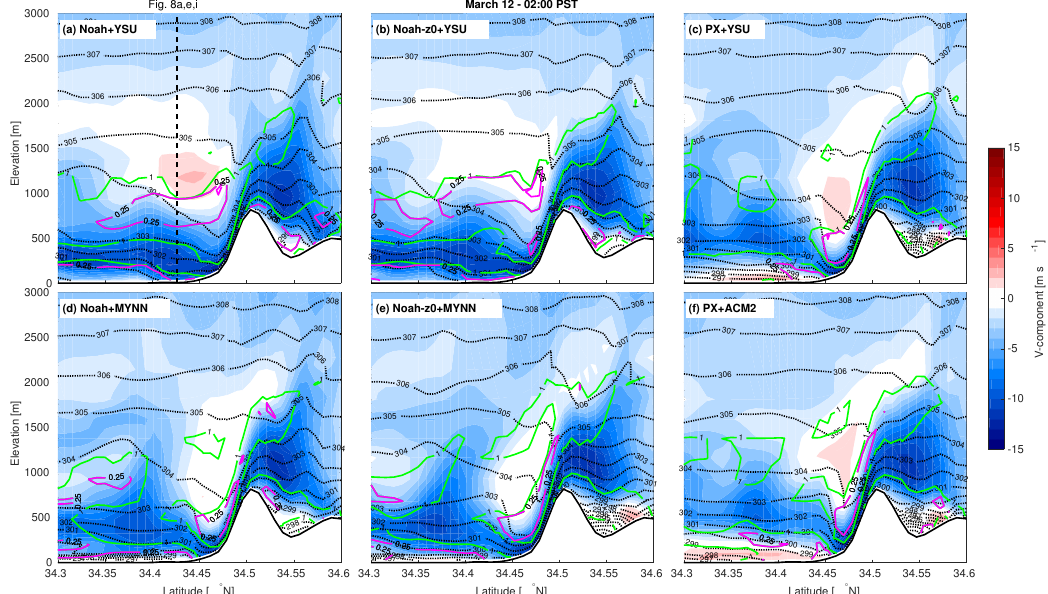
Figure 9. ( a – f ) Vertical cross sections of θ v (dotted lines), meridional wind component (colors), and regions of Ri lower than 1 (green) and 0.25 (magenta) for sensitivity runs at 02:00 PST. The vertical dashed lines in ( a ) indicate the location of vertical profiles presented in Figure 8.